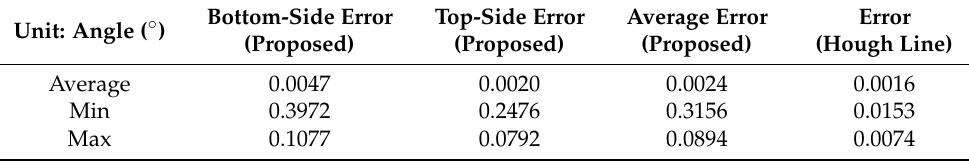
Figure 23. Measurement error.